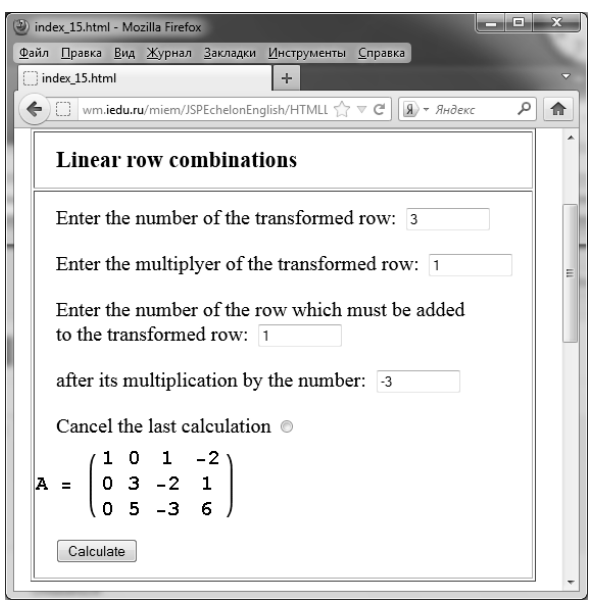
Figure 3. Linear row combinations